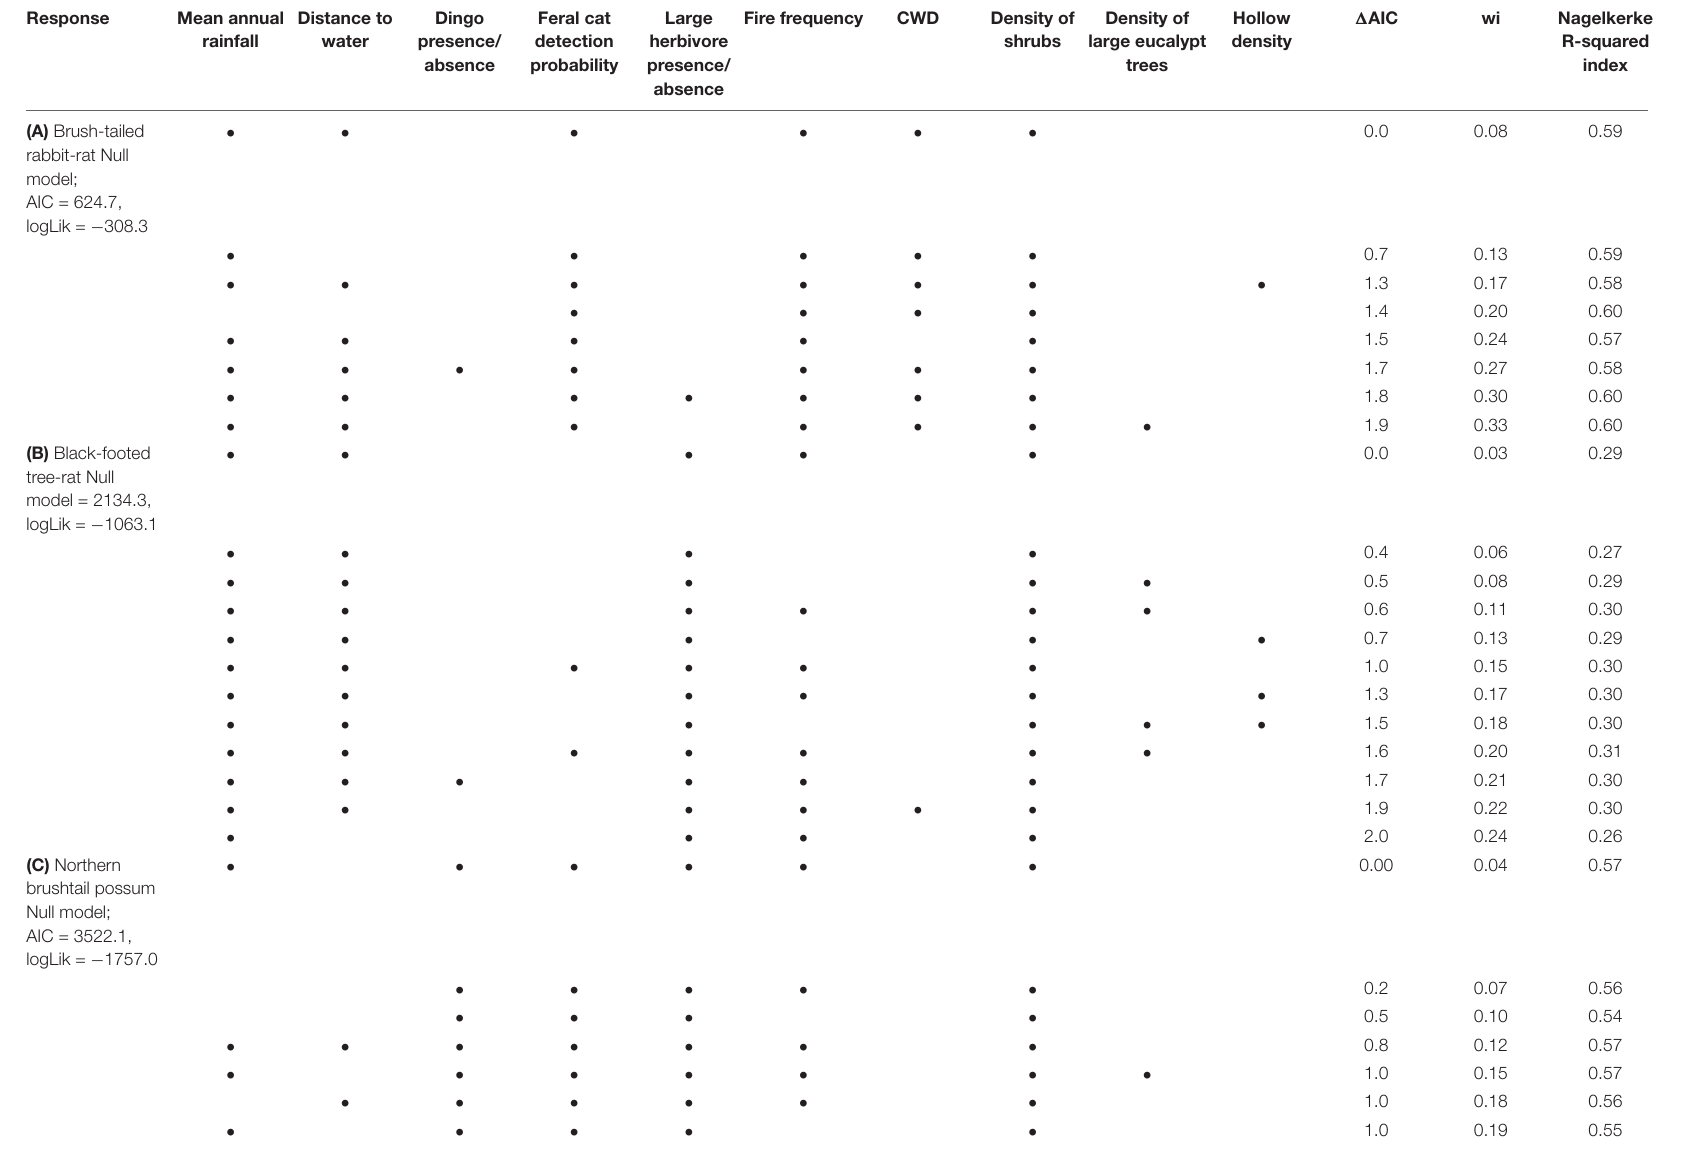
TABLE 2 | Model ranking table for the abundance three arboreal mammal species examined on Melville Island 2015: (A) brush-tailed rabbit-rat; (B) black-footed tree-rat; (C) northern brushtail possum.